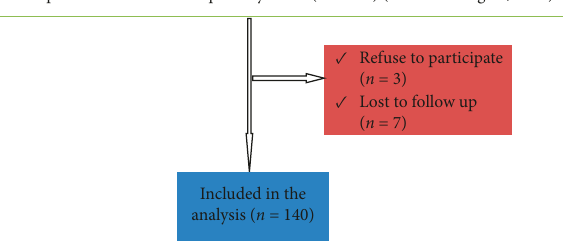
Figure 1: Summary of sampling